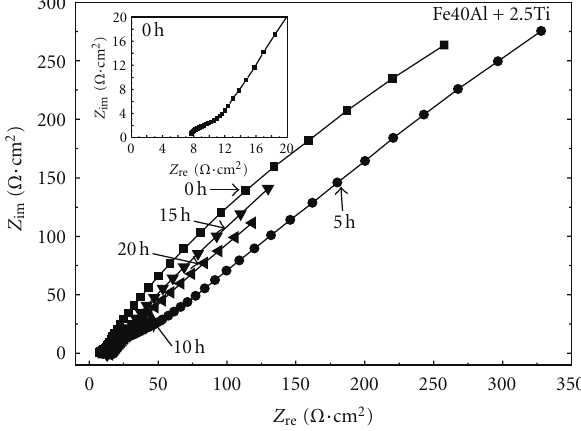
Figure 6: Nyquist diagrams for the Fe40Al + 2.5Cr alloy corroded in KCl + ZnCl 2 at 670 ◦ C.